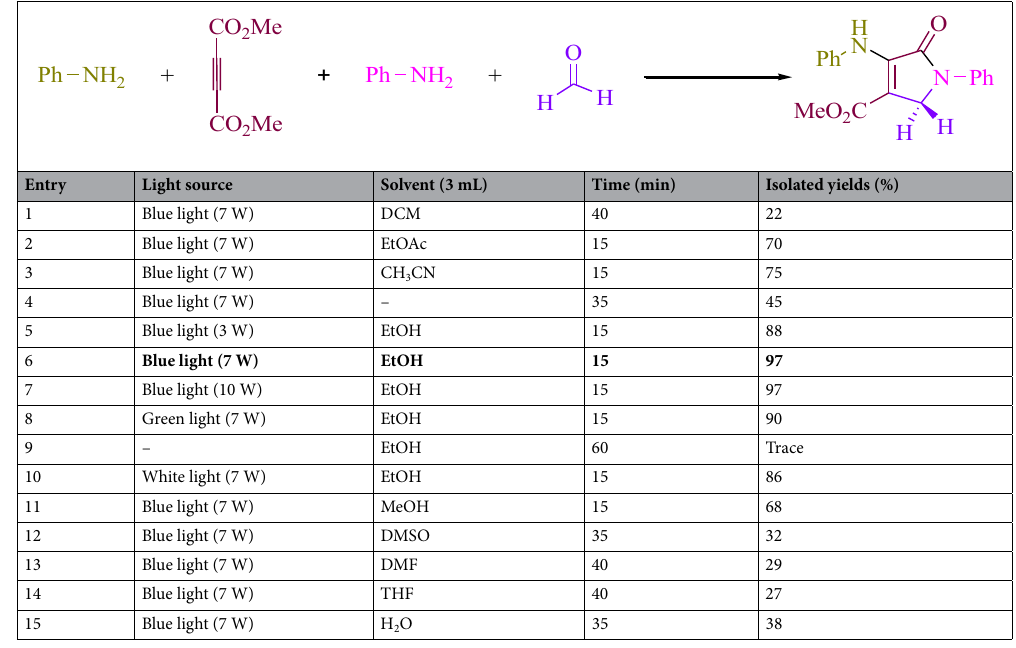
Table 2. There is a table that shows the optimal concentrations of solvent and visible light for the synthesis of 5a a . Significant values are in [bold]. a Reaction conditions: at rt, 4CzIPN (1 mol%) was mixed with formaldehyde (1.5 mmol), aniline (2 mmol), and dimethyl acetylenedicarboxylate (DMAD) (1